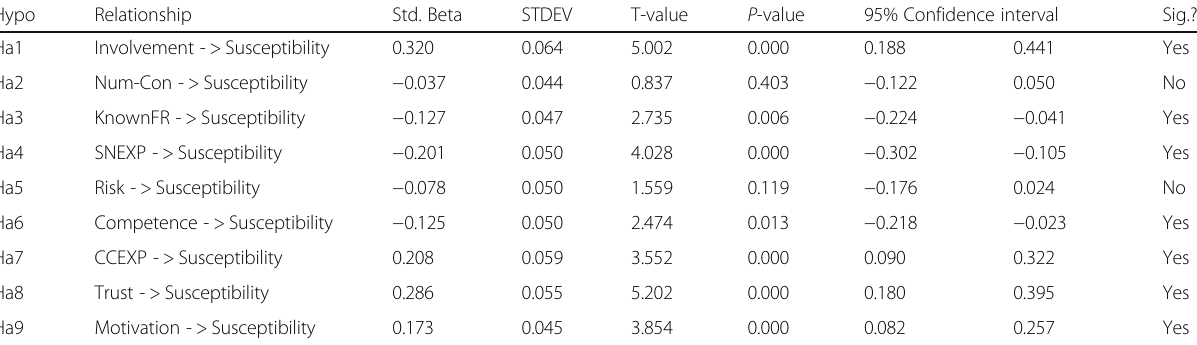
Table 6 Total effects significance testing results